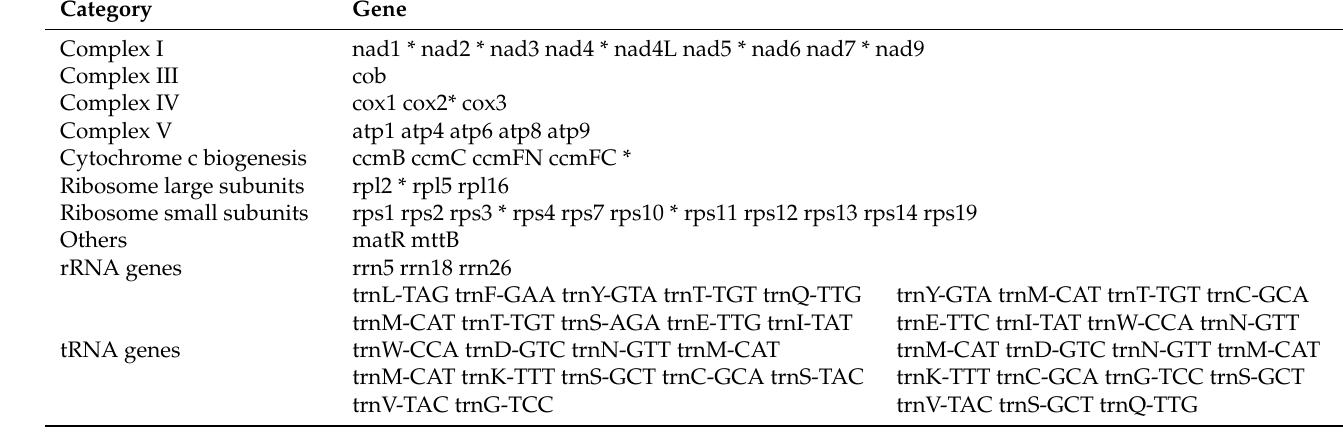
Table 2. Genes encoded in the C. lancifolium and C. macrorhizon mitogenomes. * indicates mitochon- drial genes with